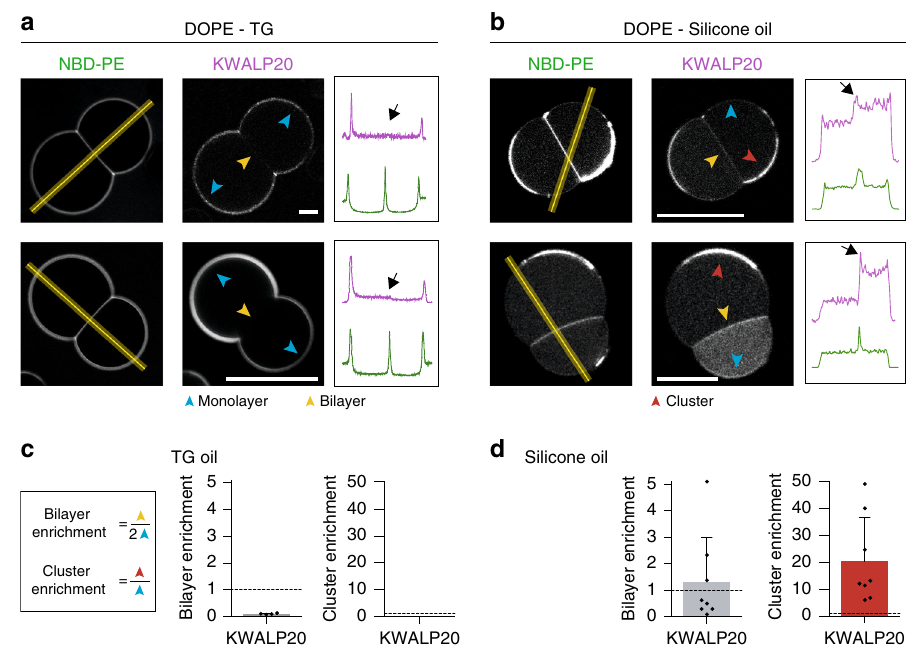
Fig. 5 The distribution of KWALP HD depends on the oil chemistry. a , b Distribution of KWALP20 in DOPE DIBs. KWALP20 is labeled with Rh-B. Oil phase is TG ( a ) or silicone oil ( b ). Blue arrows indicate the monolayers, yellow ones indicate the bilayer, and red ones indicate cluster areas. Plot pro fi les are determined using the yellow lines. The bilayer signal is indicated by a black arrow. Scale bar: 20 µ m. c , d Partition coef fi cient is reported in gray in TG ( c ) and silicone oil ( d ), as mean ± sd ( n = 2 and 8 independent measurements respectively). A cluster enrichment coef fi cient (red) is determined for the experiment in silicone oil, and is shown as mean ± SD ( n = 8 independent measurements). Each data point is shown as a black dot. Source data are provided as a Source Data fi